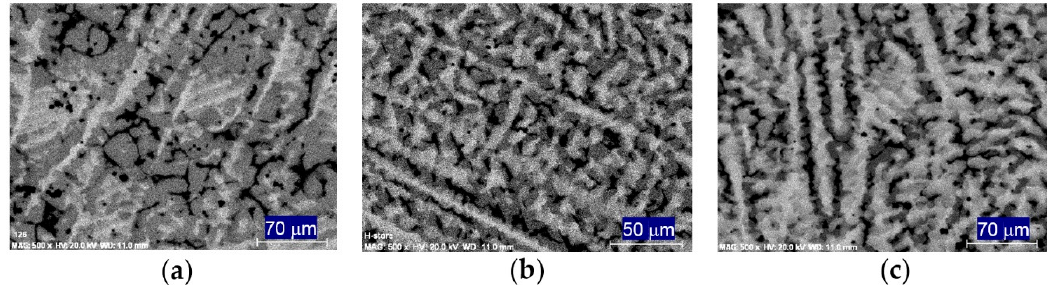
Figure 14. X-ray energy dispersive spectroscopy Cr-mapping from MH alloys with ( a ) 3.5 at % Cr and 28 wt % C14, ( b ) 5.5 at % Cr and 53 wt % C14, and ( c ) 8.5 at % Cr and 87 wt % C14. The three phases are C14, C15, and Zr x Ni y in order of decreasing brightness.